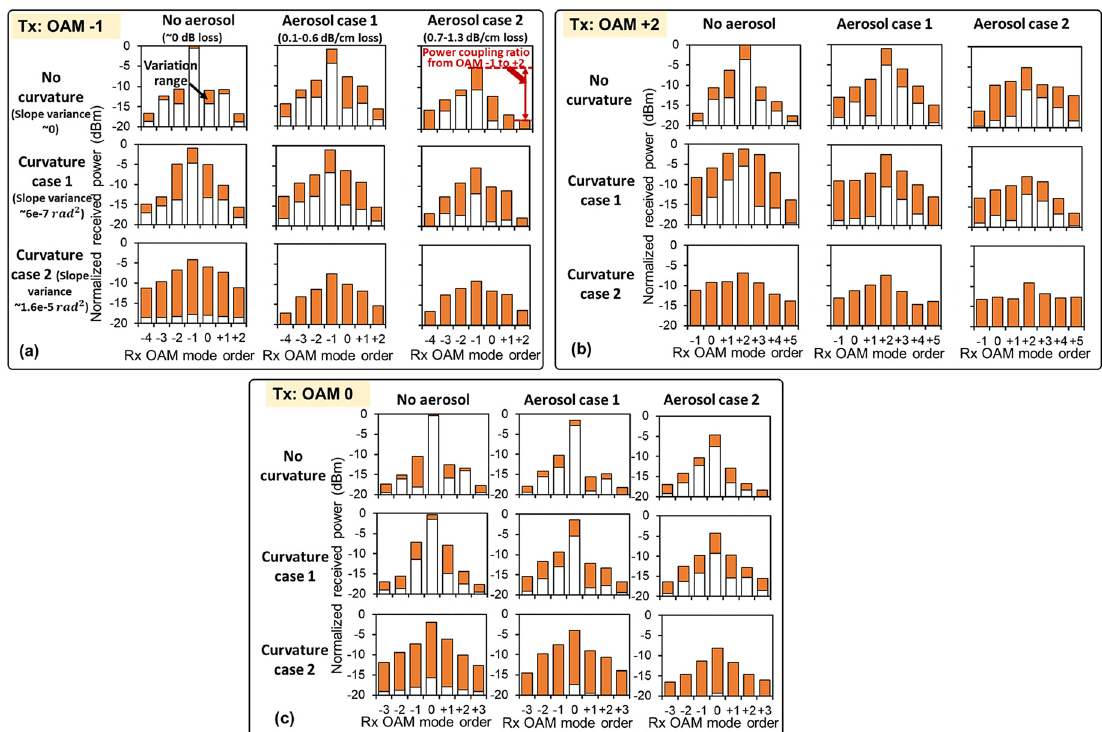
Figure 4: The received power on the transmitted modes and their neighboring modes under various aerosol and curvature conditions for (a) OAM − 1, (b) OAM + 2, and (c) OAM 0 (Gaussian beam). The beam propagation distance in aerosol is ∼ 7 cm. The orange bar shows the received power fl uctuation range during the multiple measurements over >5 s, and each measurement takes ∼ 11 ms. The incident angle is 0 (normal incidence). The power is normalized by the maximum received power for the transmitted mode in the absence of interface